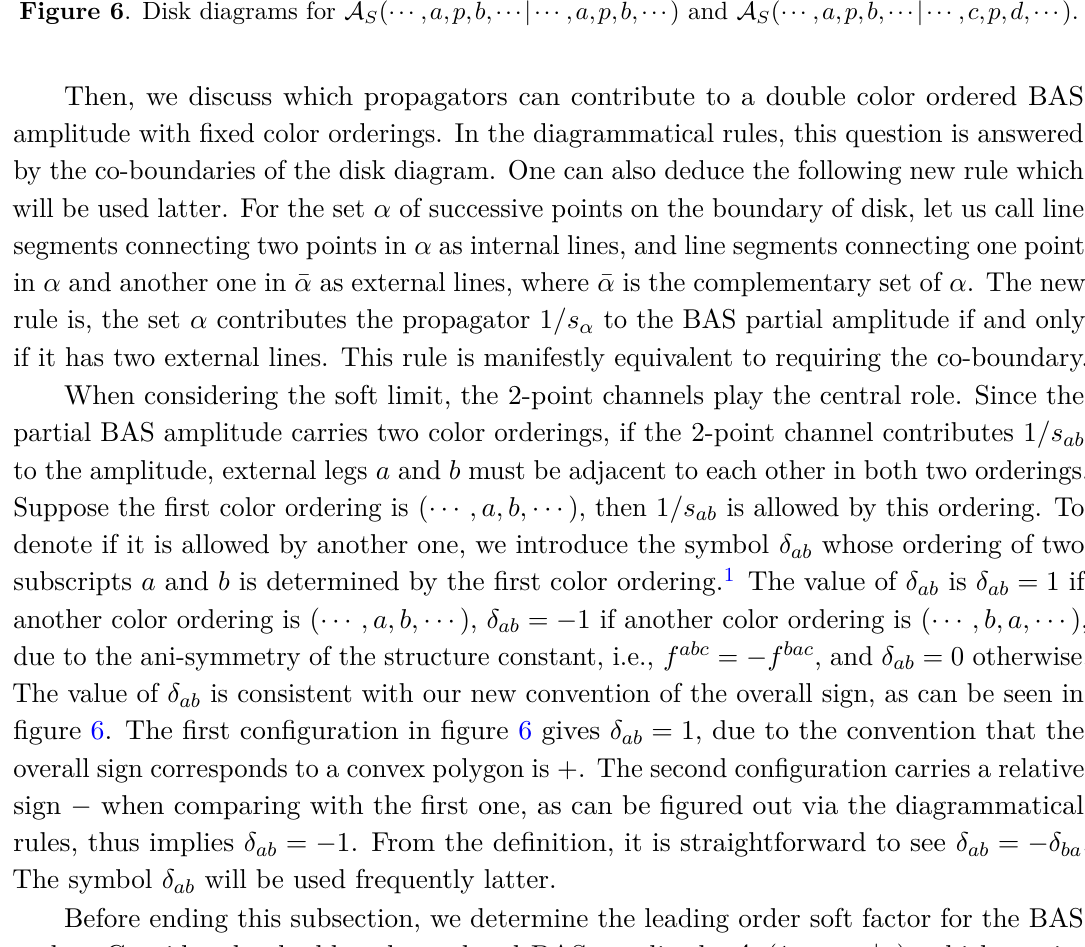
Figure 6 . Disk diagrams for A S ( ··· ,a,p,b, ···|··· ,a,p,b, ··· ) and A S ( ··· ,a,p,b, ···|··· ,c,p,d, ··· )